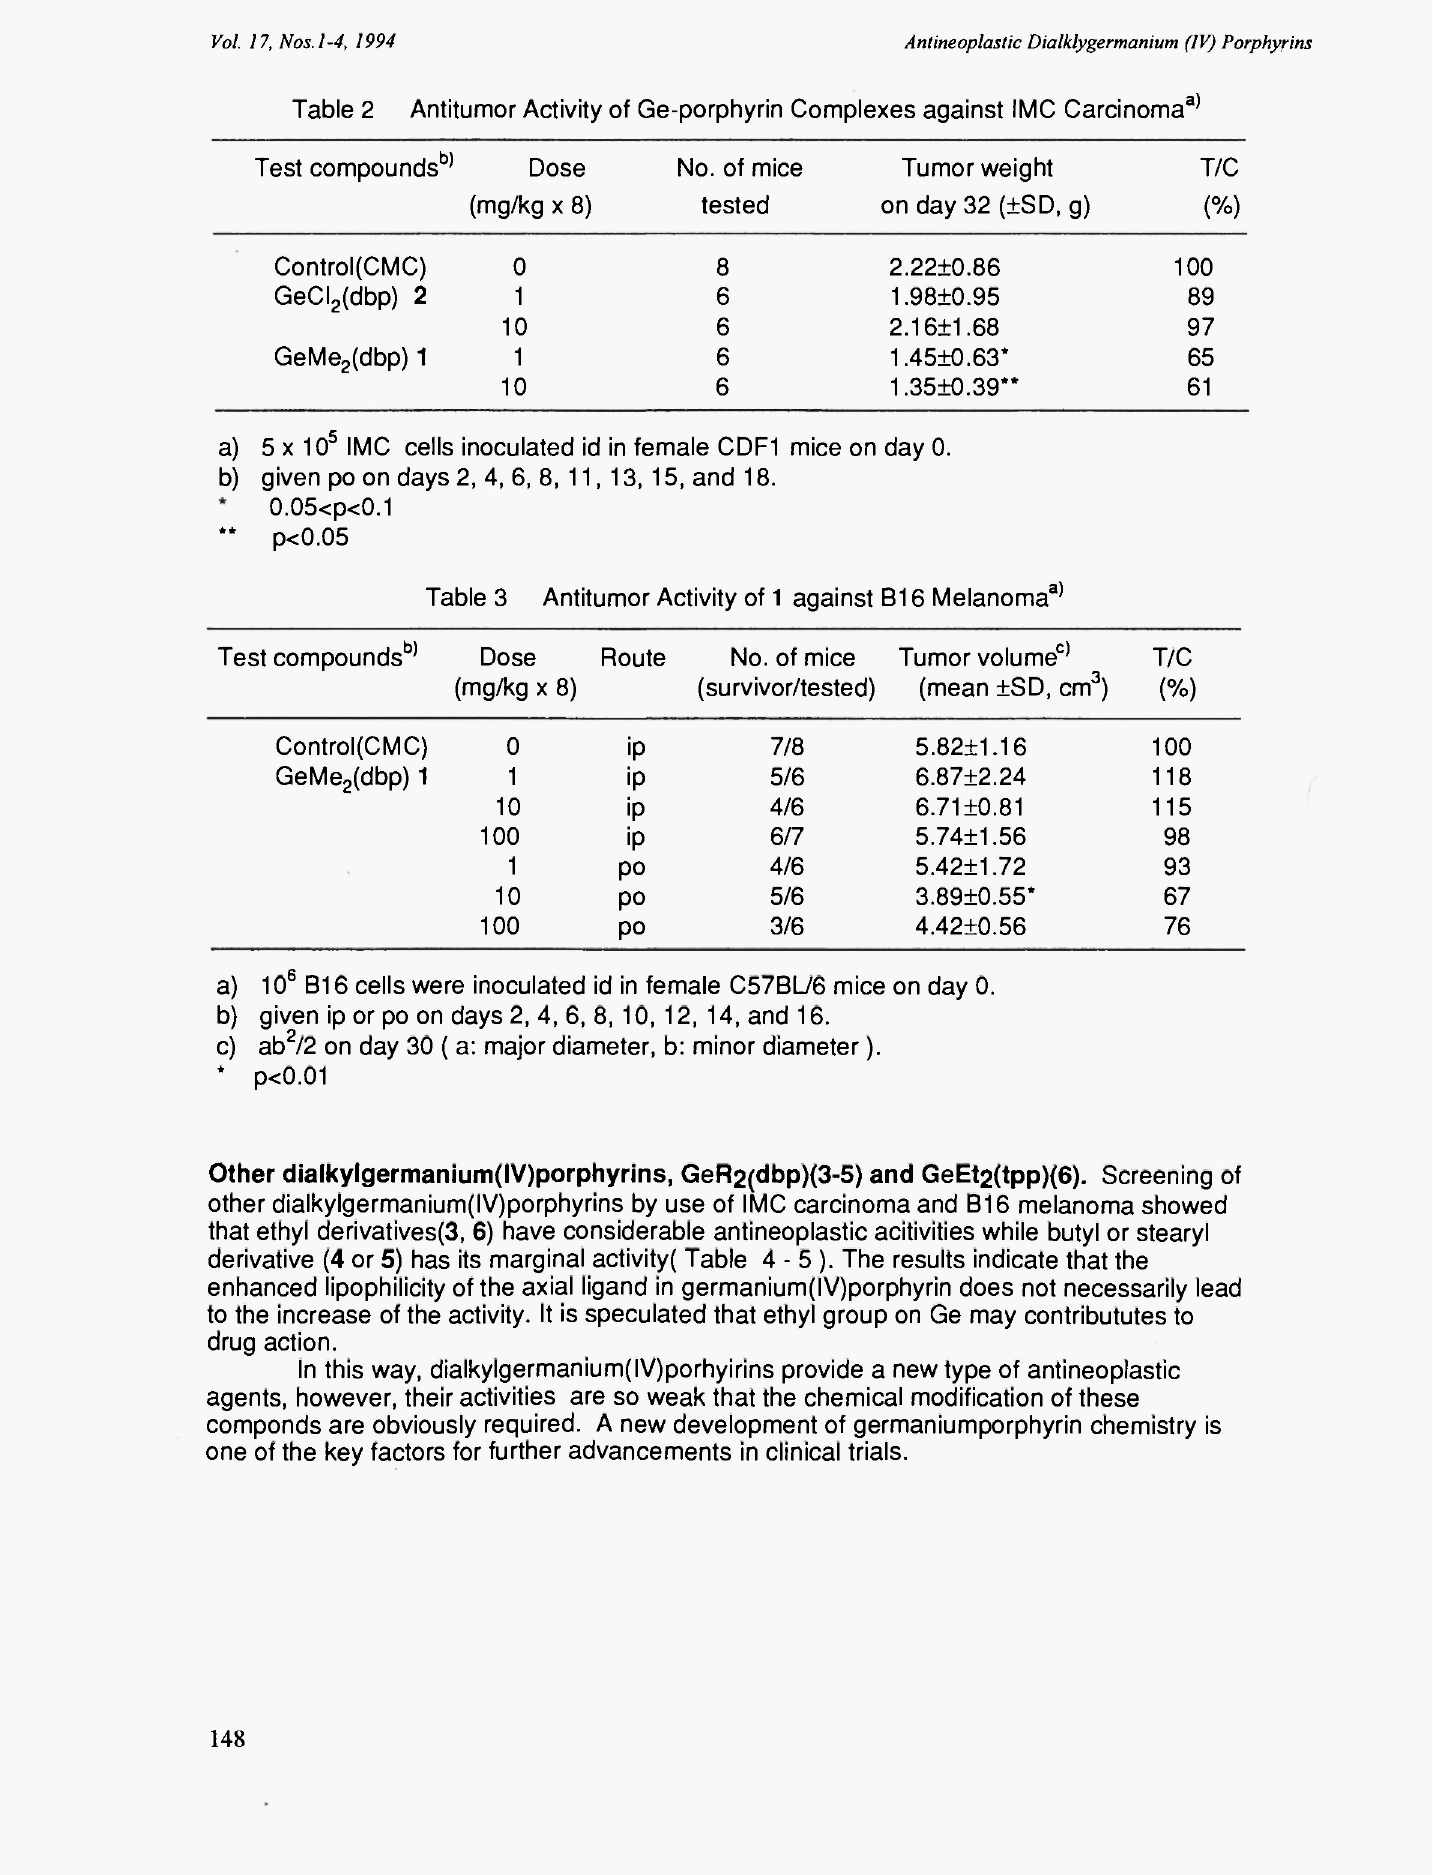
Antitumor Activity of Ge-porphyrin Complexes against IMC Carcinoma 3 ' Test compounds 6 ' Dose No. of mice Tumor weight